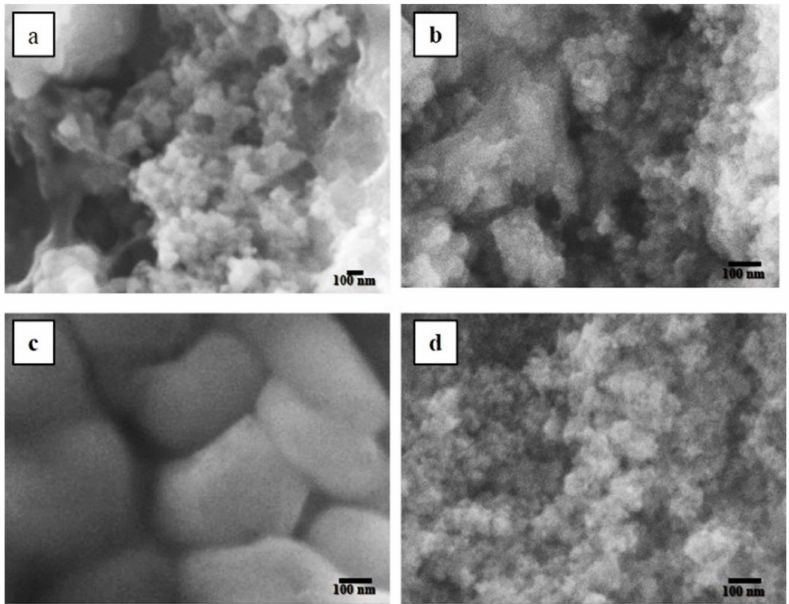
Figure 1. SEM (Scanning Electron Microscopy) images of the materials obtained from different concentrations of Na 2 SiO 3 . ( a ) Si-NPs (Silica Nanoparticles) 0.01 mM; ( b ) ORMOSIL-NPs (Organic Modified Silica Nanoparticles) 0.01 mM; ( c ) Si-NPs 0.10 M; ( d ) ORMOSIL-NPs 0.10 M. In obtaining ORMOSIL-NPs, a 2:1 mass ratio between PEG and Na 2 SiO 3 was